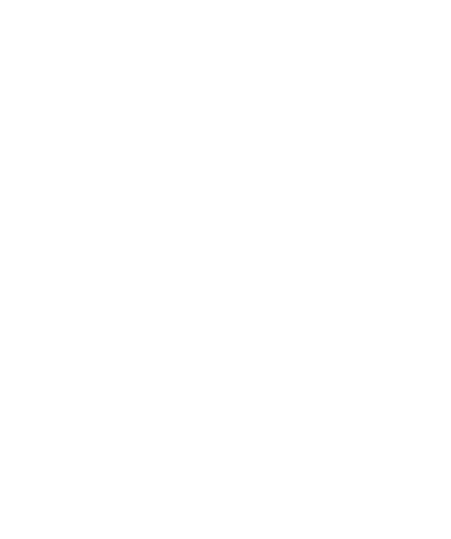
Figure 19. Location of loading during static